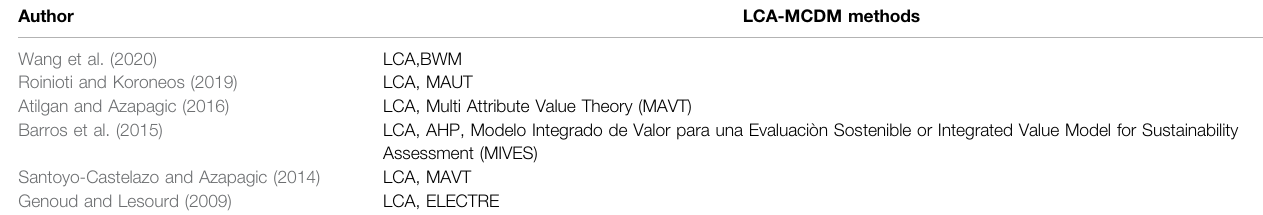
TABLE 14 | Summary of the application of LCA combined with MCDM methods.